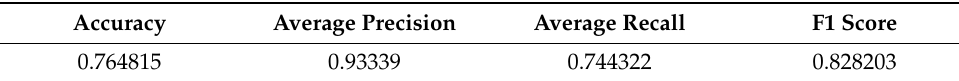
Table 1. Performance evaluation of the concrete damage detection model.